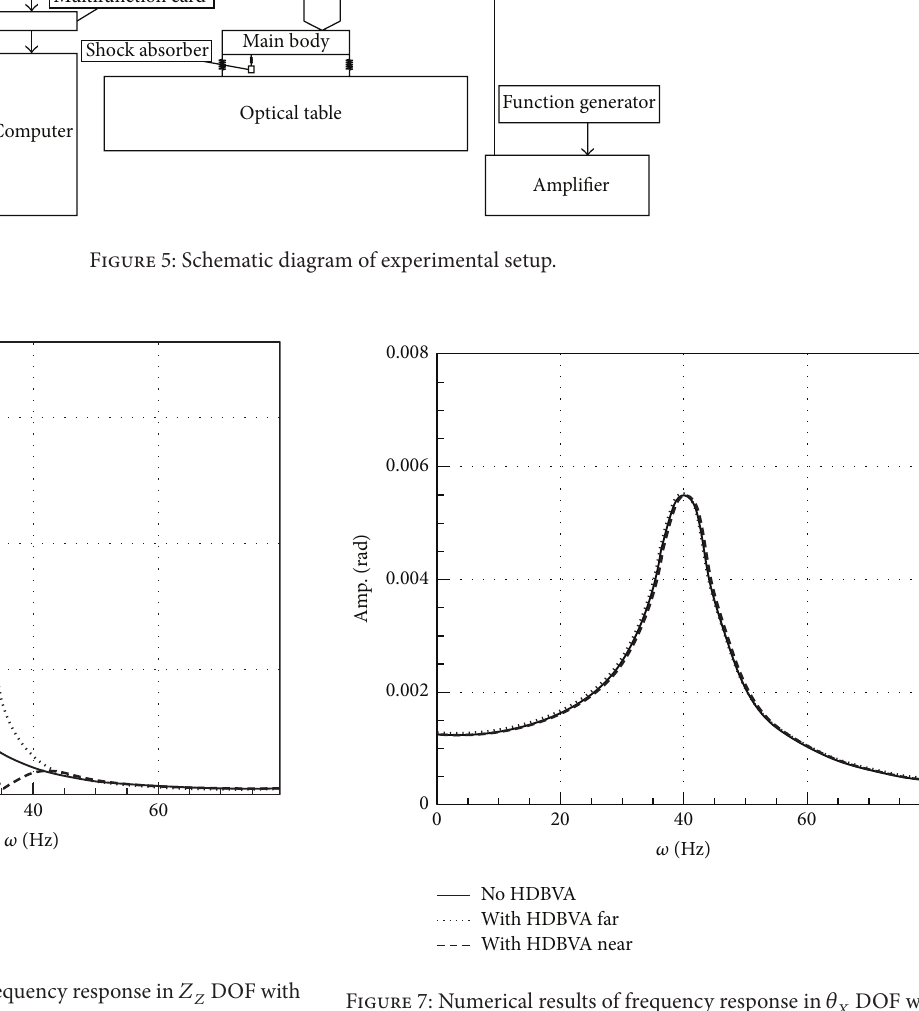
Figure 7: Numerical results of frequency response in 𝜃 𝑋 DOF with lateral